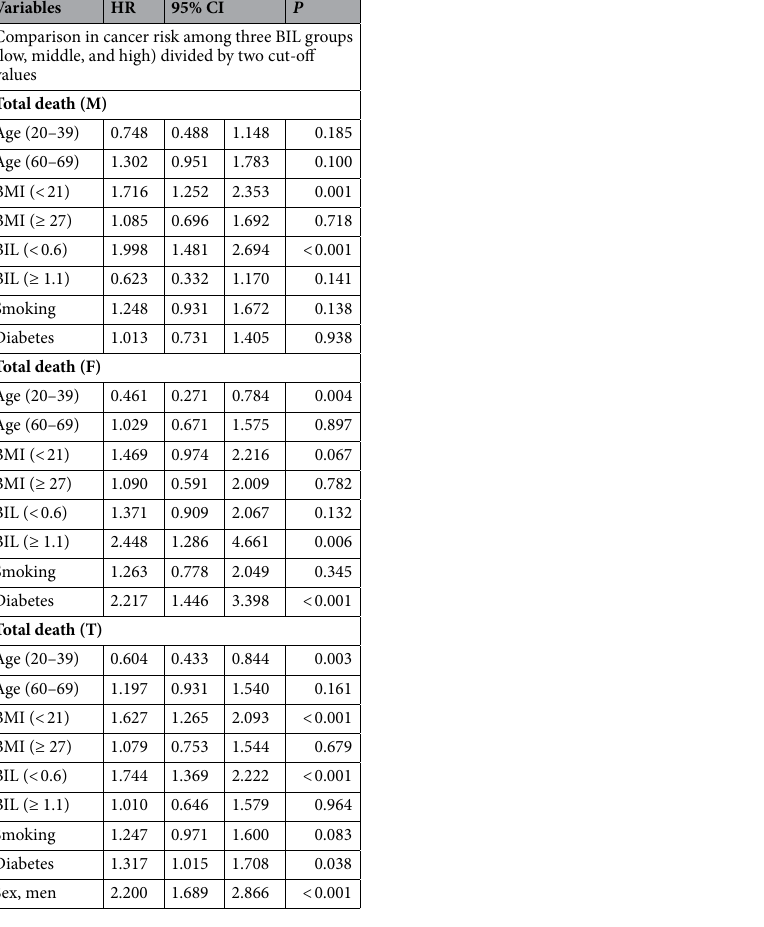
Table 4. Association between serum bilirubin levels and total all-cause death in men, women, and all subjects. The associations between serum bilirubin levels and total all-cause death in men (M), women (F), and all patients (T). Serum bilirubin levels were divided into three groups by the two cut-off values of 0.6 mg/dL and 1.1 mg/dL. The reference group for serum bilirubin levels was a middle range group. Age (20–39), subjects aged 20–39 years old; Age (60–69), subjects aged 60–69 years old; BMI (< 21), subjects with body mass index < 21 kg/m 2 ; BMI (≥ 27), subjects with body mass index > 27 kg/m 2 ; BIL (< 0.6), subjects with bilirubin levels < 0.6 mg/dL; BIL (≥ 1.1); subjects with bilirubin levels > 1.1. The reference of age and BMI was a middle range